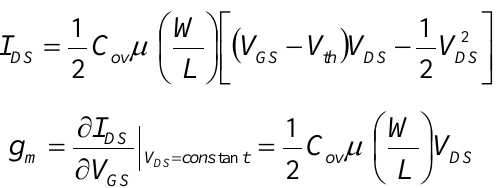
-V and transconductance (gm) curves of ZrO DS GS